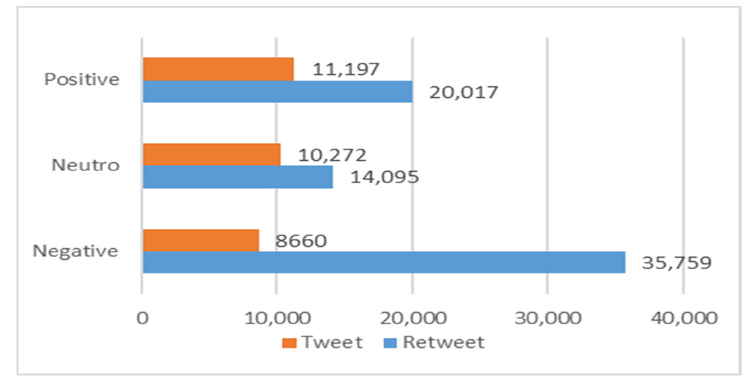
Figure 13. Polarity of tweets and retweets (period 1).